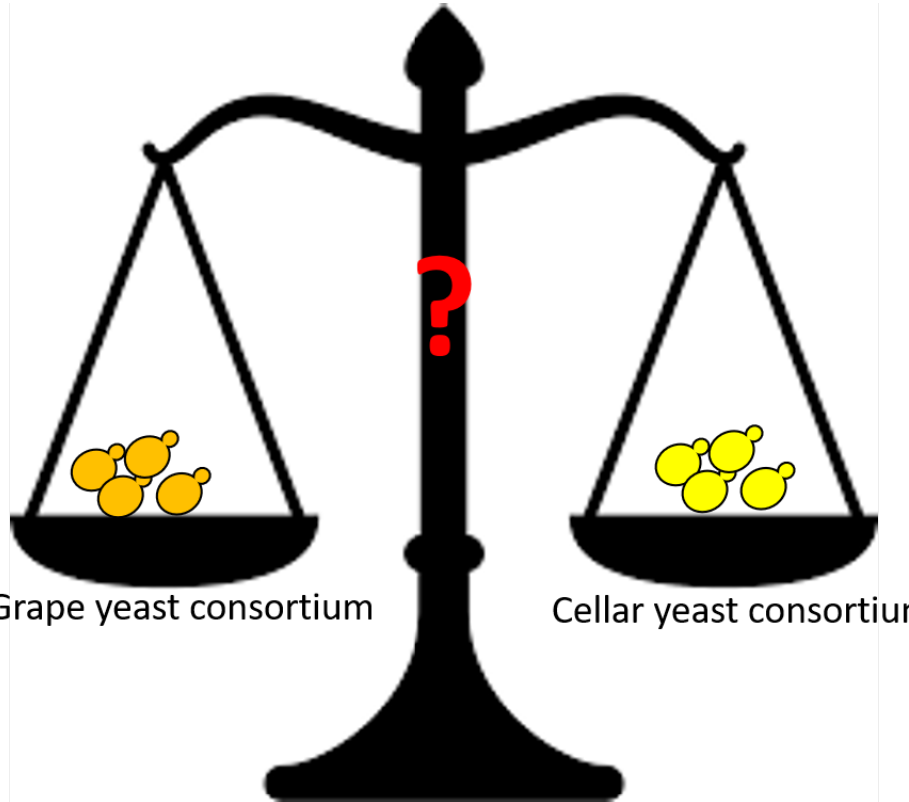
Figure 2. Does Microbial terroir exist? Who is the main player in wine typicality? Terroir yeast from grapevine or cellar yeast?